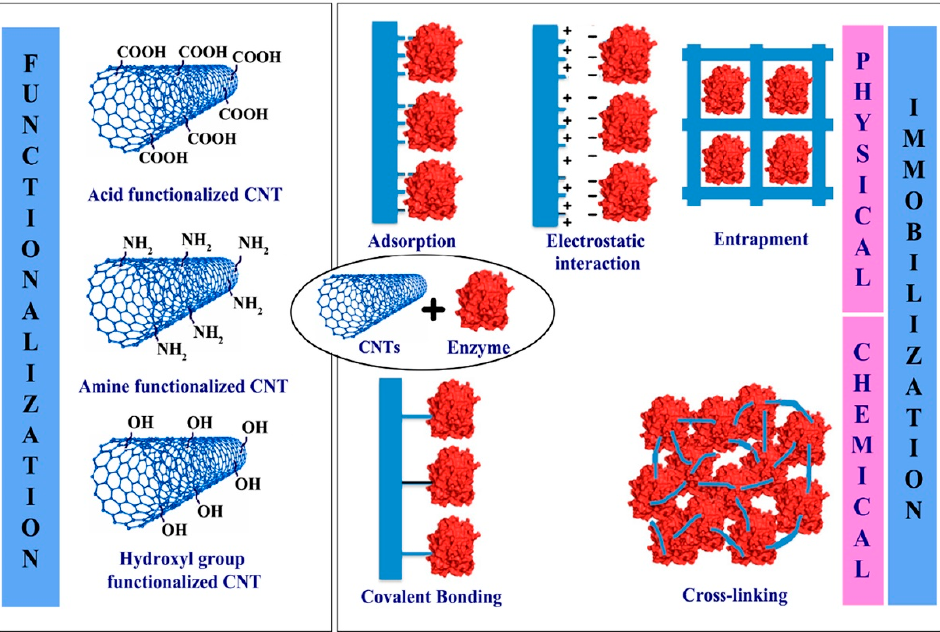
Figure 9. Schematic illustration of the functionalization of CNT and enzyme immobilization method. Image reproduced with permission from [169]. Copyright 2021 Elsevier.